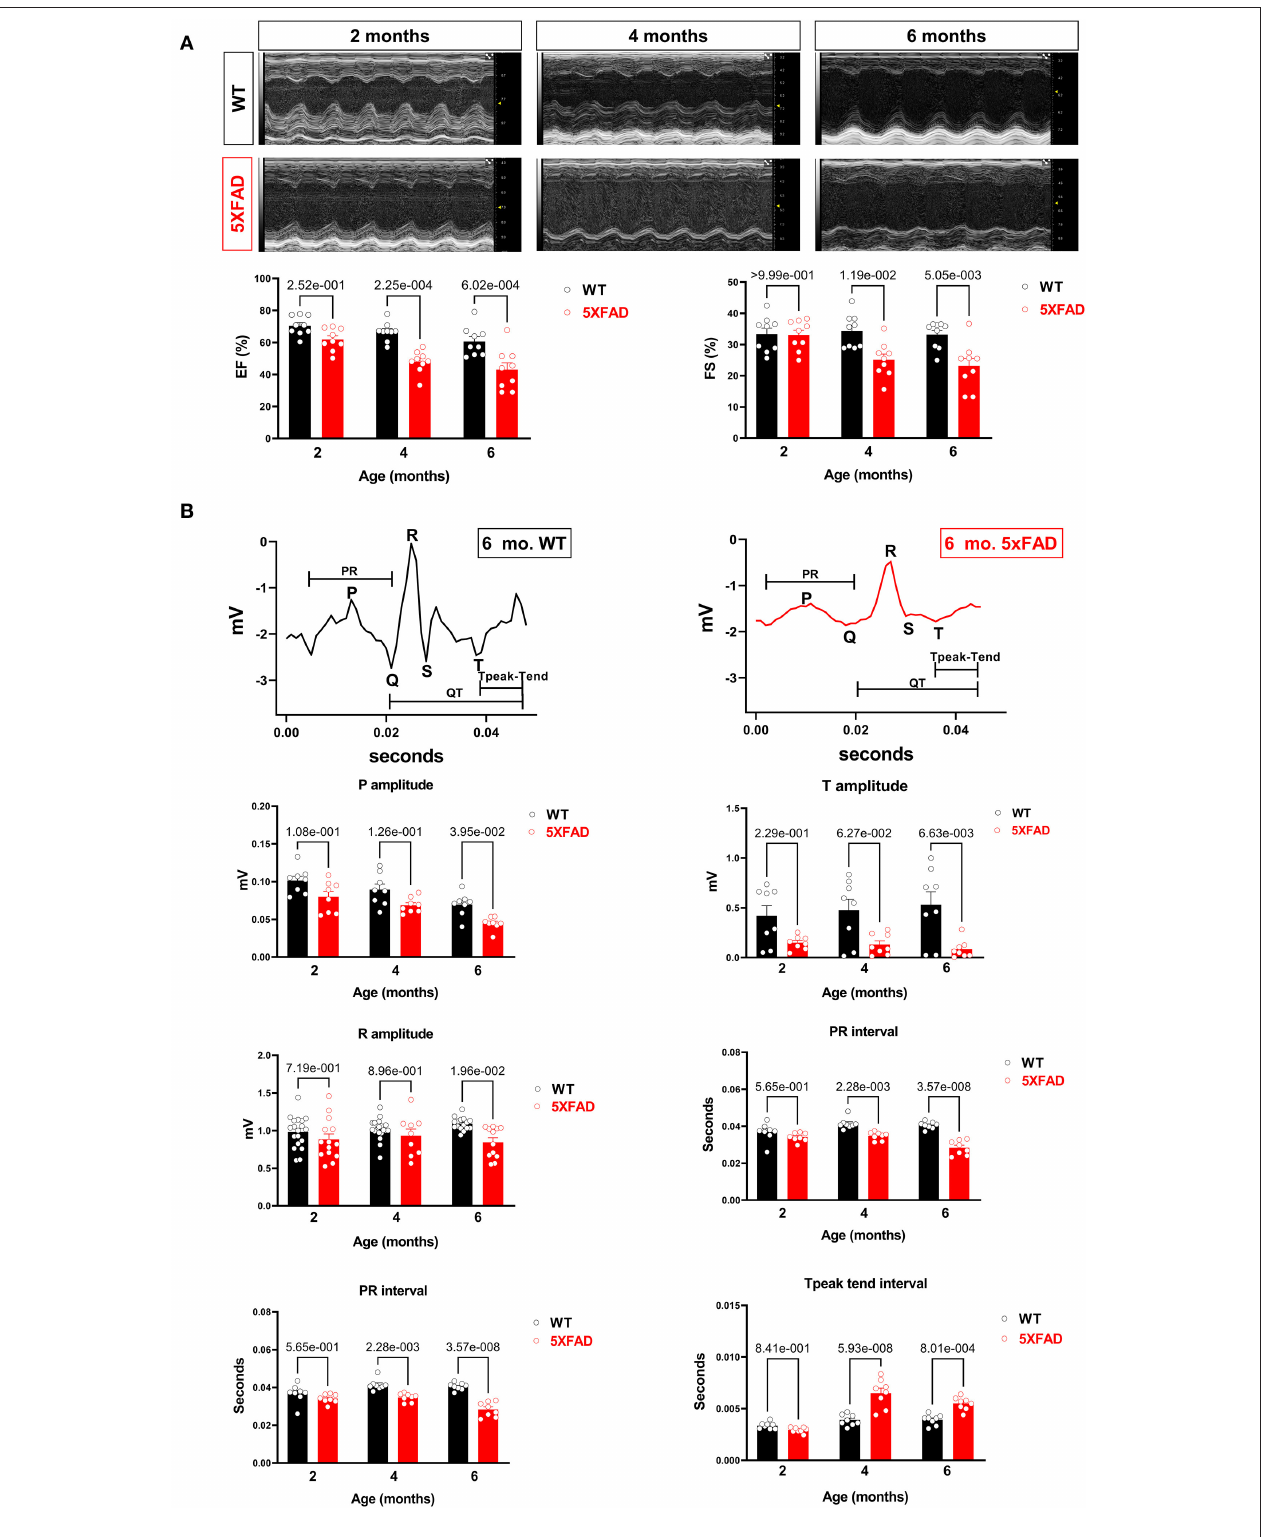
FIGURE 1 | Cardiac systolic dysfunction in 5XFAD compared to WT mice chronologically. (A) Echocardiography showed that 5XFAD mice developed progressive cardiac systolic dysfunction over time with reduced left ventricular function as shown by ejection fraction (EF) and fractional shortening (FS). Upper: